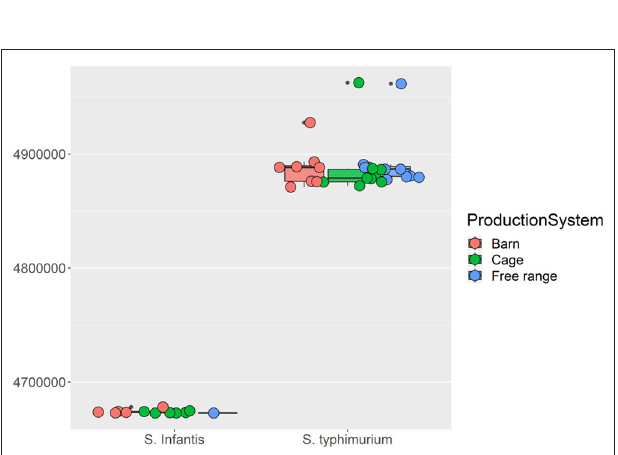
FIGURE 3 | The boxplots of the isolates genome sizes. The Salmonella Infantis and Salmonella Typhimurium serotypes were grouped separately by the three different egg production systems, namely, barn, cage, and